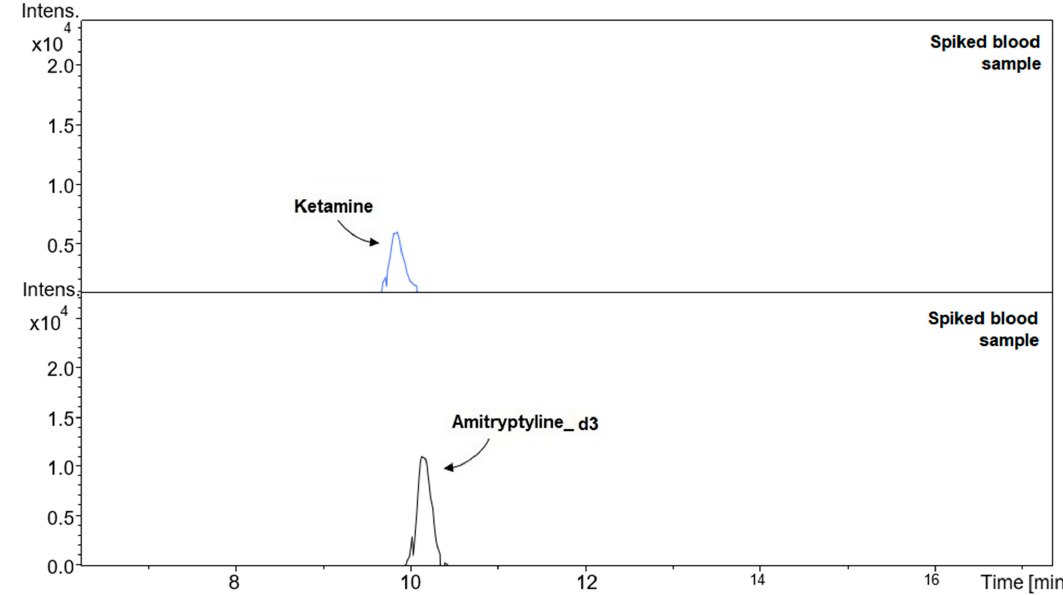
Figure 3. Electropherograms of spiked blood samples (ketamine at the LOQ level—20 ng/mL: t m = 9.08 ± 0.4; amitriptyline- d3 at a concentration of 150 ng/mL: t m = 10.3 ± 0.5).